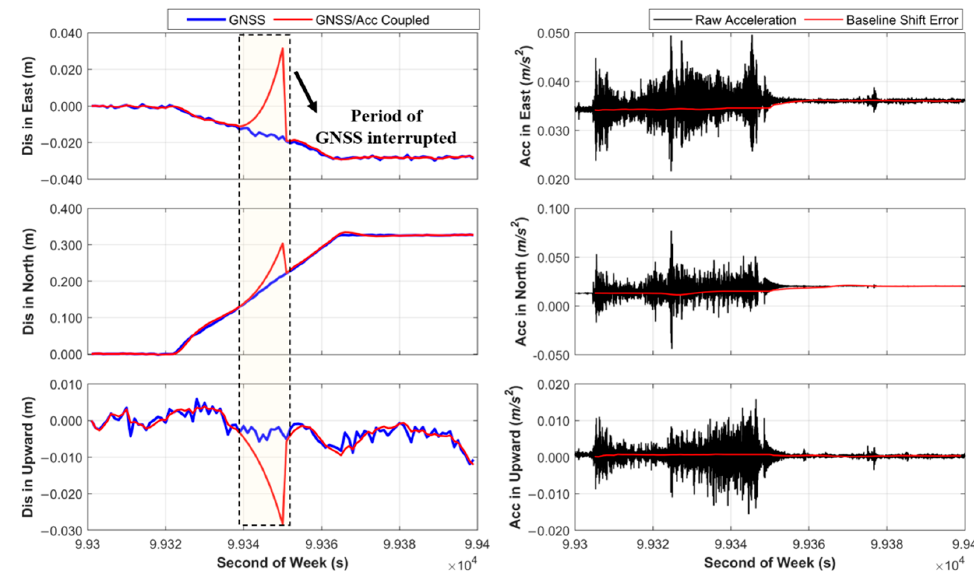
Figure 16. Coupled displacement ( left ) and BSE results ( right ) of the simulated landslide sliding period in Scene 3. Table 10. RMS statistical results when simulating landslide sliding period in Scene 3 (unit: cm).